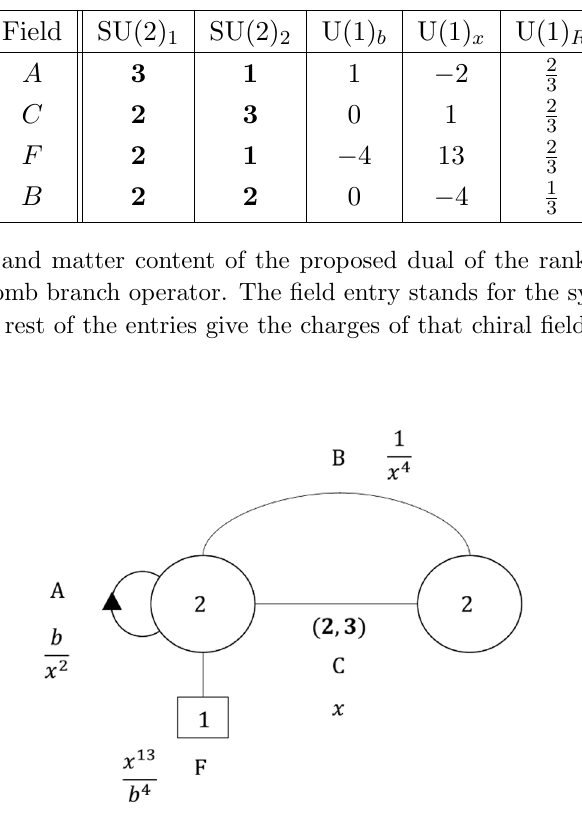
Figure 1 . The quiver diagram of the proposed N = 1 model. As usual in quiver diagrams, circles represent gauge symmetries while boxes represent (cid:13)avor ones. Next to each matter (cid:12)eld is written its symbol as well as its charges under the global non-R symmetries. Finally we note that the ( 2 ; 3 ) below the line associated with the (cid:12)eld C gives it representations under the two SU(2)